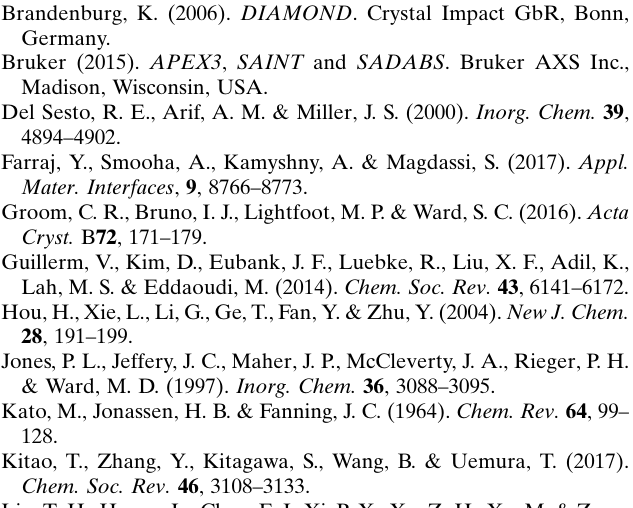
Table 3 Experimental details. Crystal data Chemical